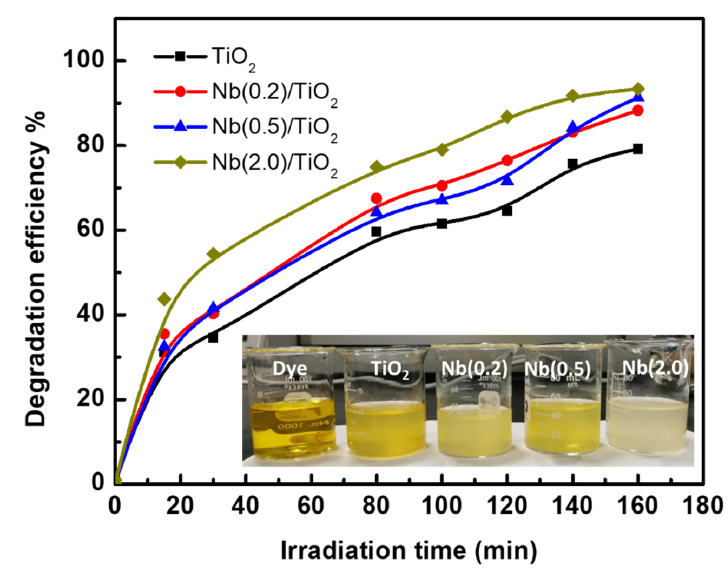
Figure 8. The efficiency of photocatalytic degradation for Phenol red with a concentration of 20 mg/L on the surface of TiO 2 , Nb(0.2)/TiO 2 , Nb(0.5)/TiO 2 , and Nb(2.0)/TiO 2 . The inset shows the dif-